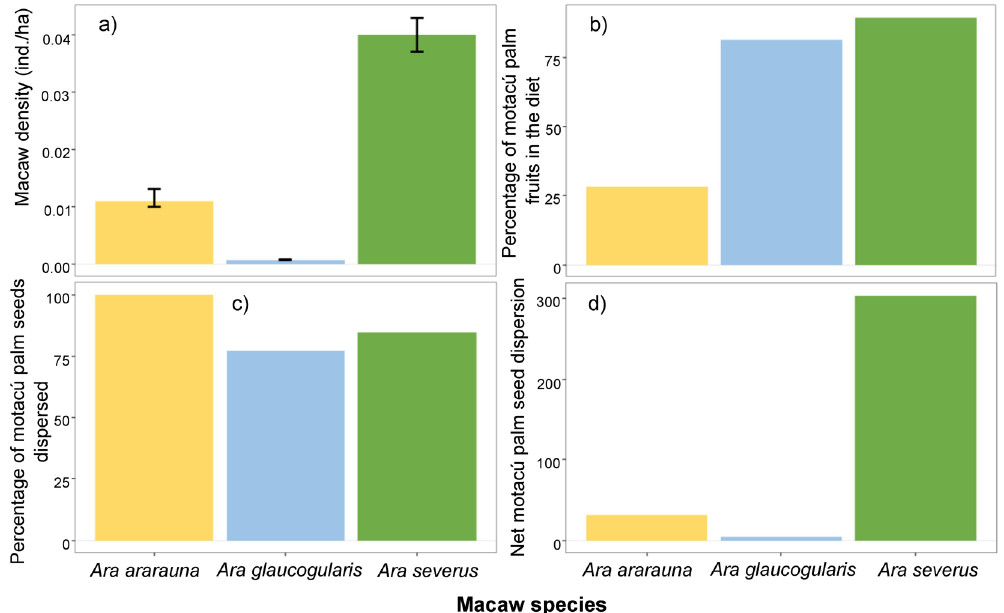
Figure 4. Dispersal contribution of each macaw species. ( a ) Observed macaw density (mean ± 95% CI individuals/ha); ( b ) percentage of motacú palm in diet; ( c ) percentage of dispersed among handled motacú palm seeds; ( d ) net motacú palm seed dispersal by macaw species (Macaw density * % motacú palm fruits in the diet * % motacú palm seeds